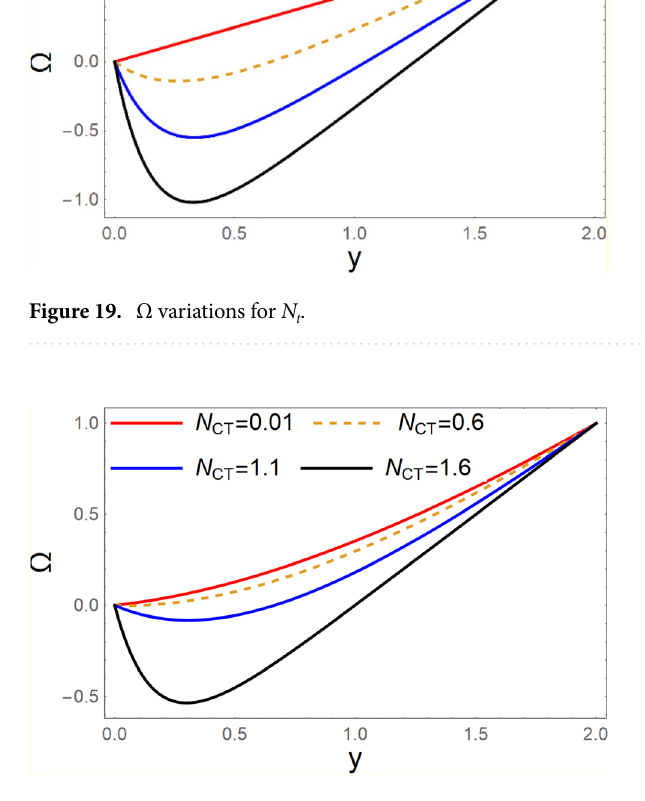
Figure 20. Ω profile for N CT .